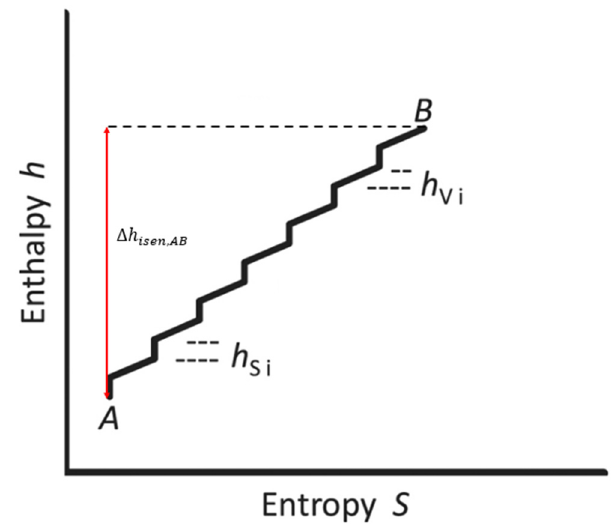
Figure 3. Definition of polytropic efficiency.